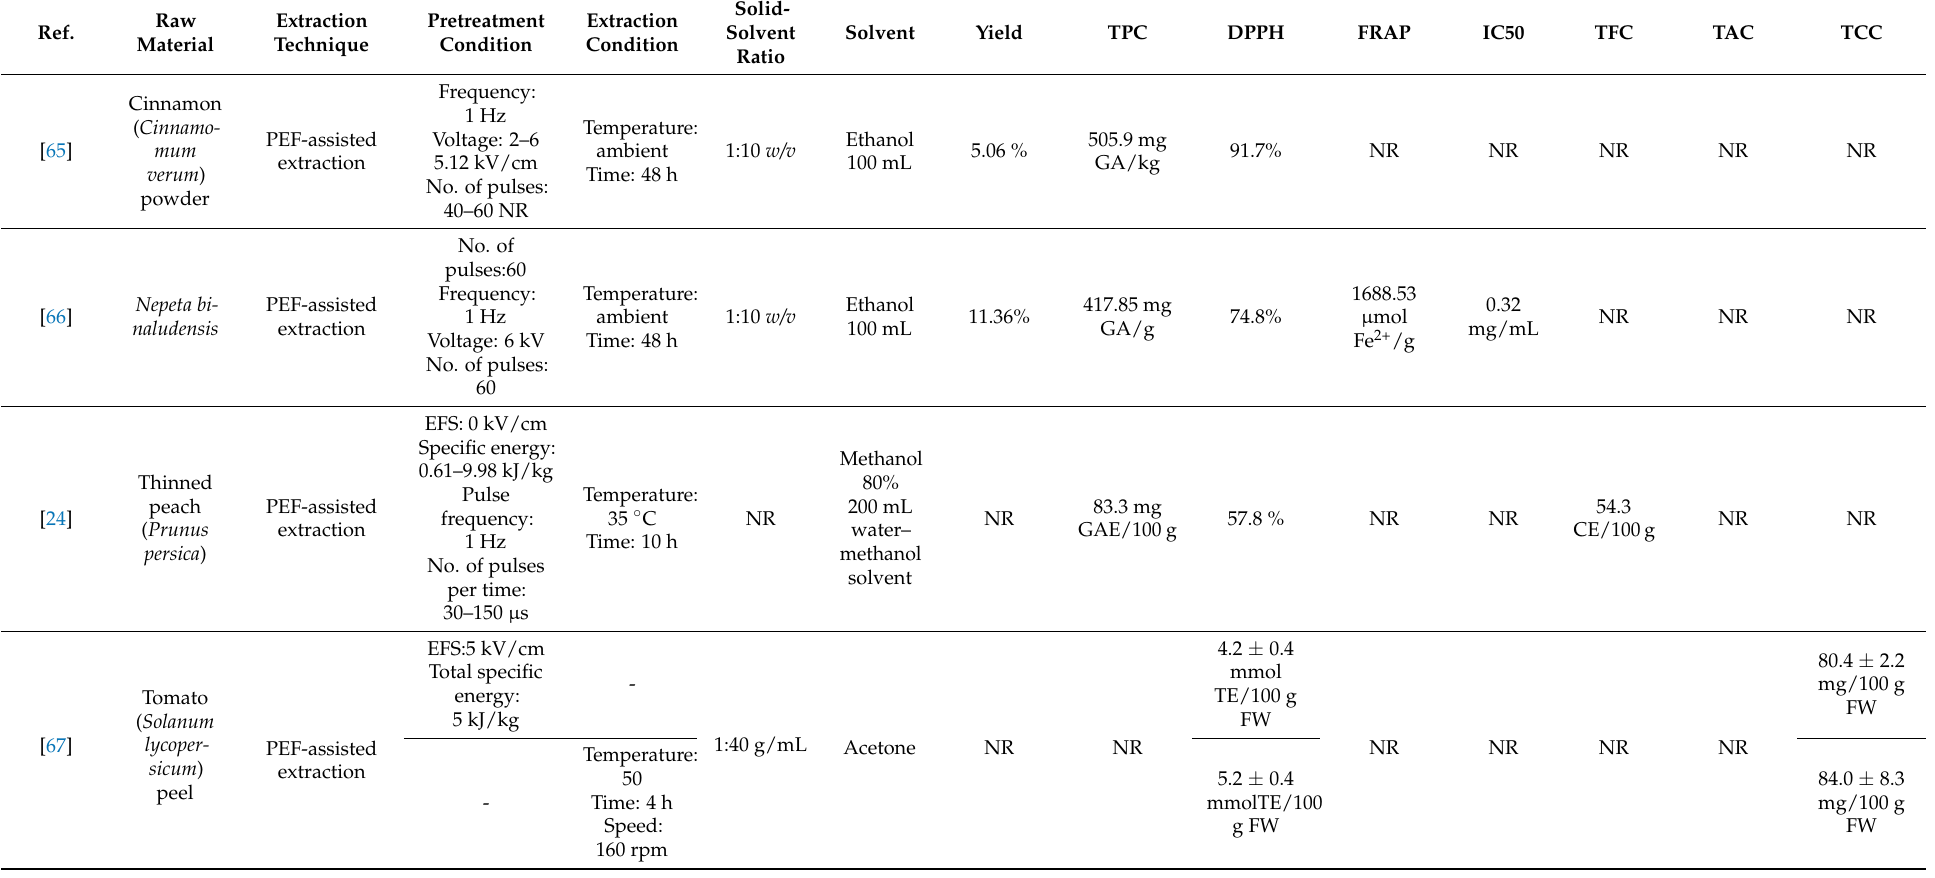
Table 1. PEF Assisted extraction of Bioactive